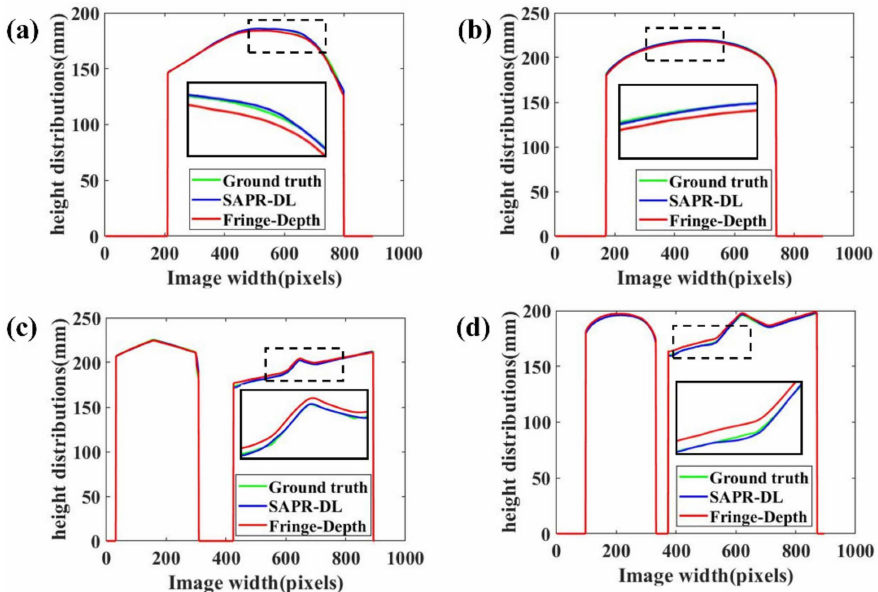
Figure 7. Depth distributions. ( a ) The depth distributions of the 590th row for scenario 1. ( b ) The depth distributions of the 450th row for scenario 2. ( c ) The depth distributions of the 159th row for scenario 3. ( d ) The depth distributions of the 251st row for scenario